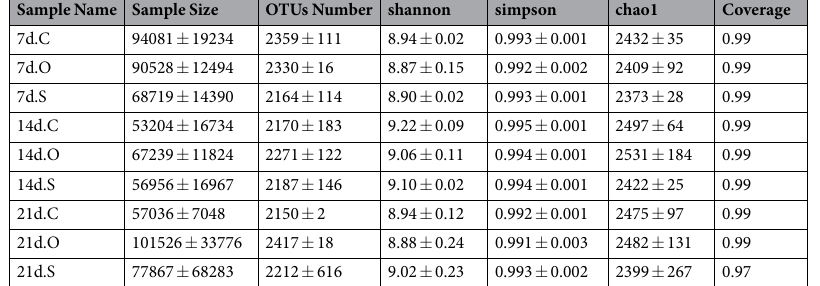
Table 1. Richness, diversity and sample coverage for high-throughput sequencing with bacterial 16S rRNA gene libraries of soil microorganisms. 7d: 7 days, 14d: 14 days, 21d: 21 days, C: control, O: organic acid, S: